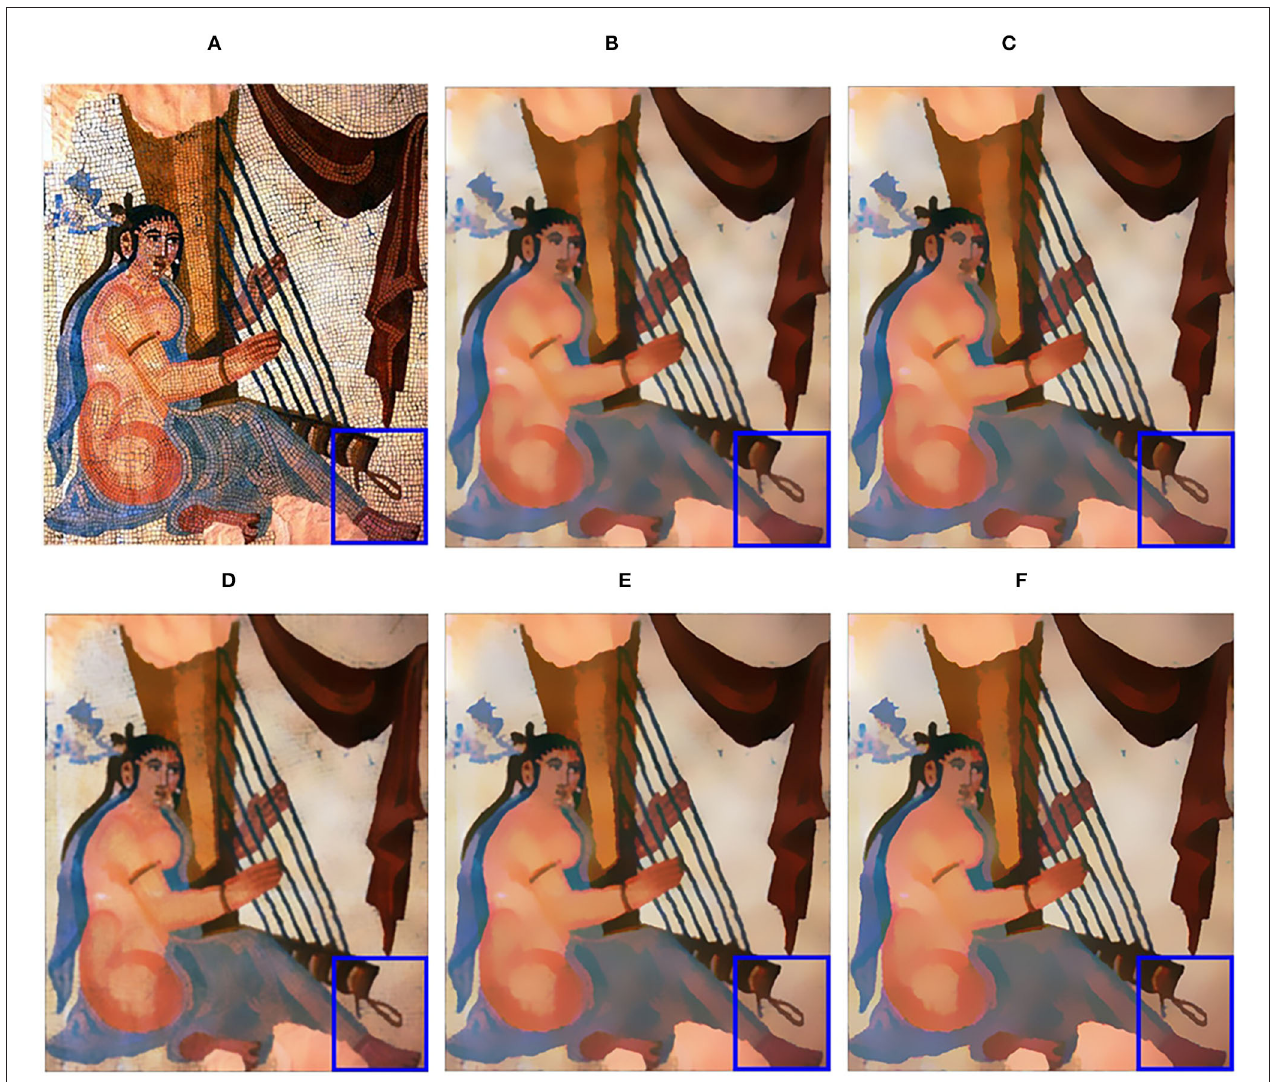
FIGURE 3 | Filtering results with various parameter combinations. (A) Input image; (B) η = 10, I = 2; (C) η = 10, I = 3; (D) η = 15, I = 1; (E) η = 15, I = 2; (F) η = 15, I = 3. Reproduced with permission from Li Xu, Qiong Yan, Yang Xia, Jiaya Jia, available at http://www.cse.cuhk.edu.hk/%7eleojia/projects/texturesep/.